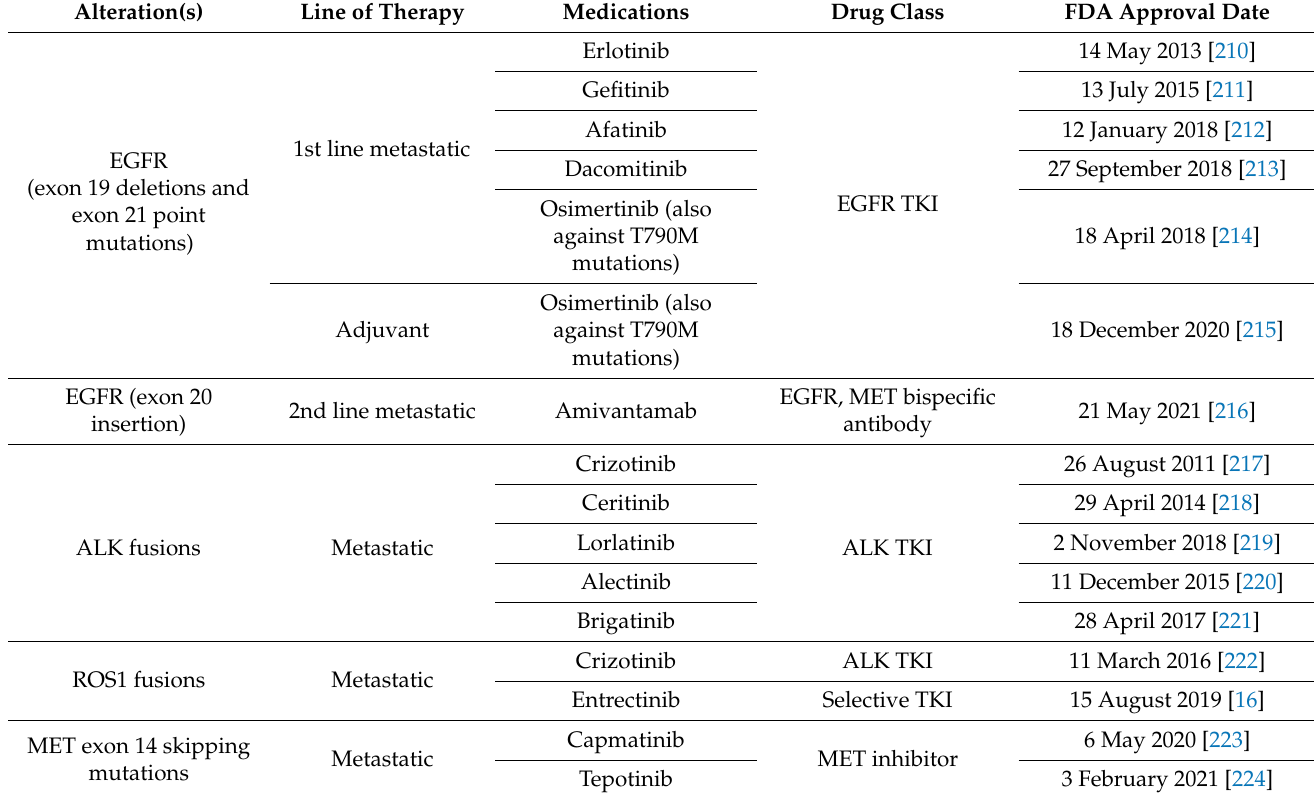
Table 4. Molecular alterations leading to FDA-targeted therapy approvals only in